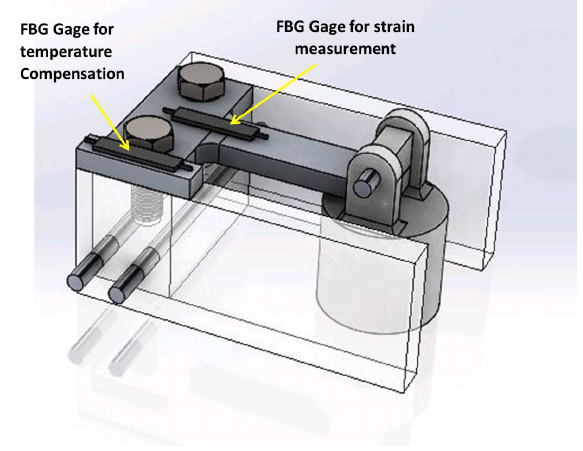
Figure 14. Sensor prototype with proposed temperature